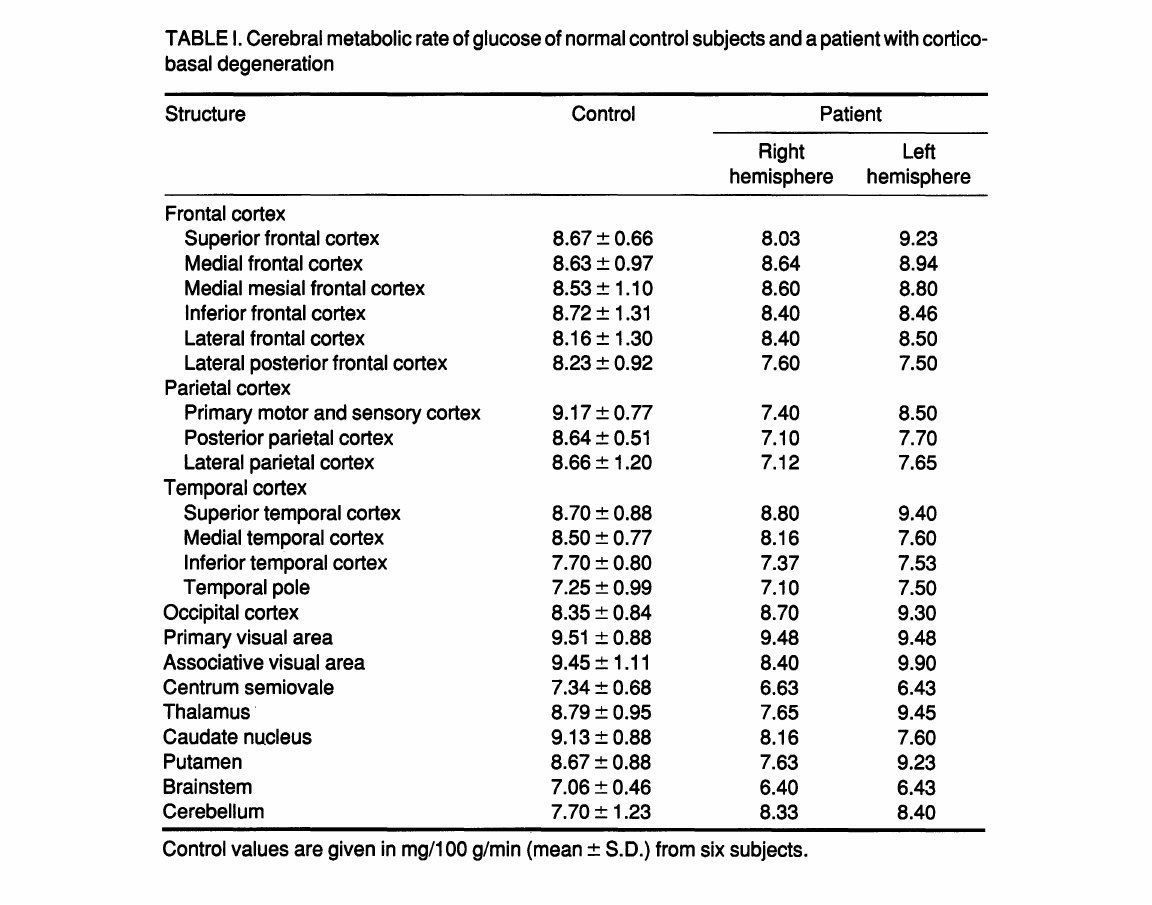
TABLE I. Cerebral metabolic rate of glucose of normal control subjects and a patient with cortico basal degeneration